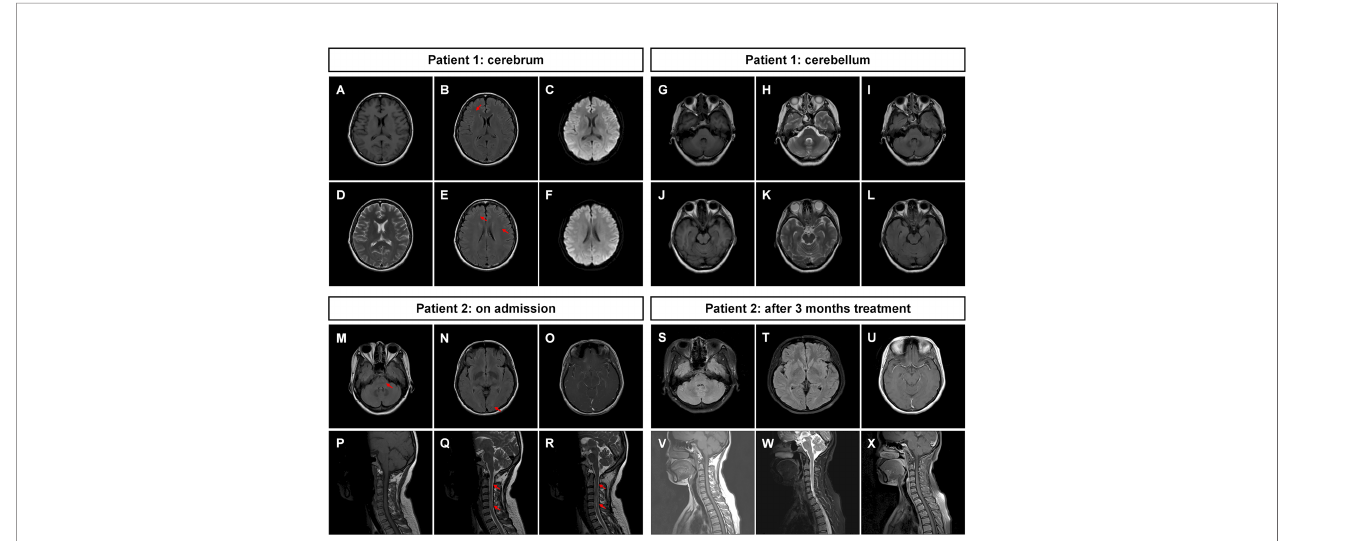
FIGURE 1 | Magnetic resonance images of the patients. (A – F) Brain MRI of patient 1 was not remarkable with mild whiter matter abnormalities (indicated by arrows). (G – L) The MRI of cerebellum was not remarkable. (M – O) Brain MRI of patient 2 showed multiple abnormal signals in white matter in the bilateral cerebral hemisphere and brainstem (indicated by arrows). (P – R) The spine MRI of patient 2 showed long-segment spinal cord lesions from medulla to the C6 segment (indicated by arrows). After 3 months of treatment, (S – U) the brain MRI of patient 2 showed that the abnormal signals in the white matter and brainstem were reduced compared with those in (M – O) . (V – X) The cervical MRI showed that the original abnormal signals in the spinal cord had disappeared. T1-weighted images: (A) , (G) , (J) , (P) , (V) ; T2-weighted images: (D) , (H) , (K) , (Q) , (R) , (W) ; T2 fl uid-attenuated inversion recovery sequence: (B) , (E) , (I) , (L) , (M) , (N) , (S) , (T) ; T1- weighted images with contrast: (O) , (U) , (X) ; diffusion-weighted imaging sequence: (C) , (F)